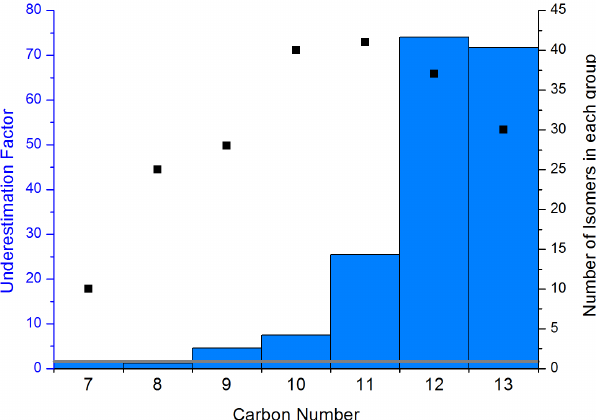
Figure 6. Winter emissions inventory underestimation (left axis and blue columns) and the number of isomers included in each grouped set of compounds (right axis and black squares). Grey line shows a factor of 1, i.e., inventory emission estimation is consistent with the